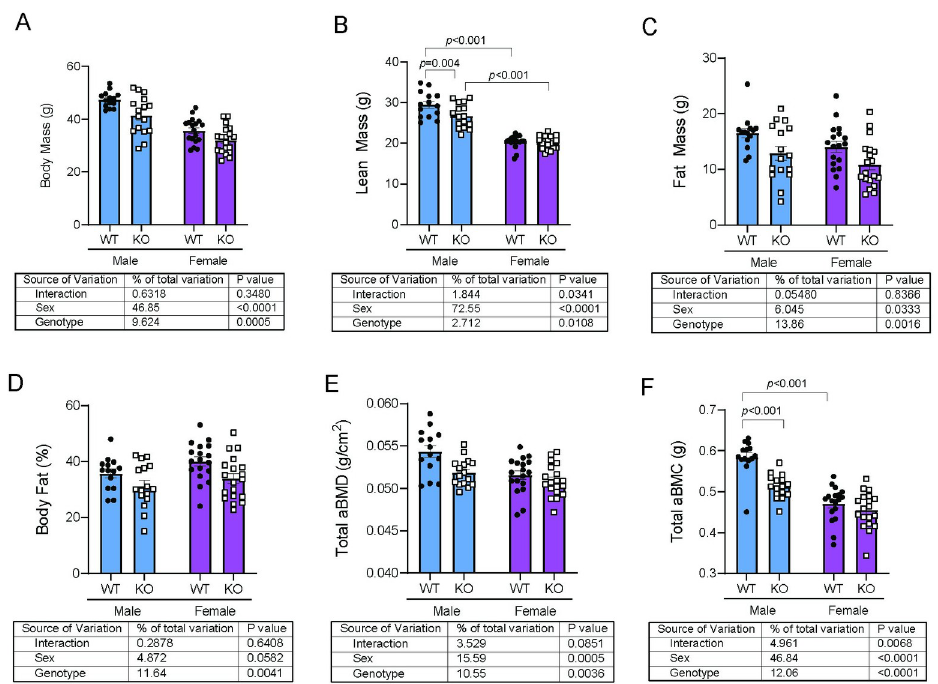
Fig 1. Trpm8 deletion causes reduced body mass, lean mass and bone density in male mice. (A-D) Body composition in 52-week old male (blue) and female (purple), wildype (closed circles) and Trpm8-KO (open squares) mice was analyzed by DXA. (E, F) Areal total body bone mineral density (aBMD) and areal bone mineral content (BMC) were measured excluding the head. N = 14-19/group. Data are expressed as individual points with bars representing mean ± SEM. Tables below each panel indicate results of the two-way ANOVA, with p- values for sex, genotype, and their interaction. p -values above the bars represent results from Holm-Sidak post hoc test for pairwise significance after a significant interaction